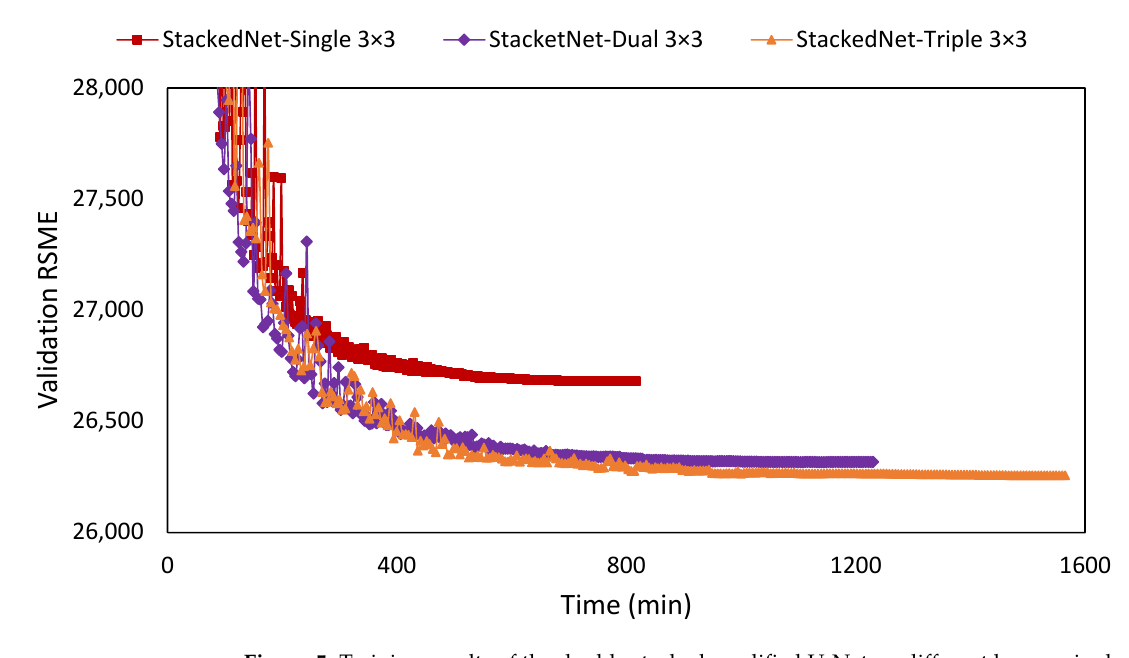
Figure 5. Training results of the double stacked-modified U-Net on different layers: single, dual, and triple layers with 3 × 3 filters. Rather than the epoch number, the X-axis represents time in minutes to indicate the training length for 300 epochs.